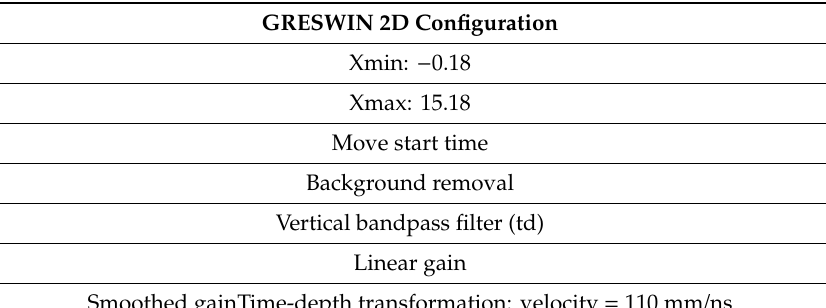
Table 7. Configuration for data processing in GRESWIN 2D.